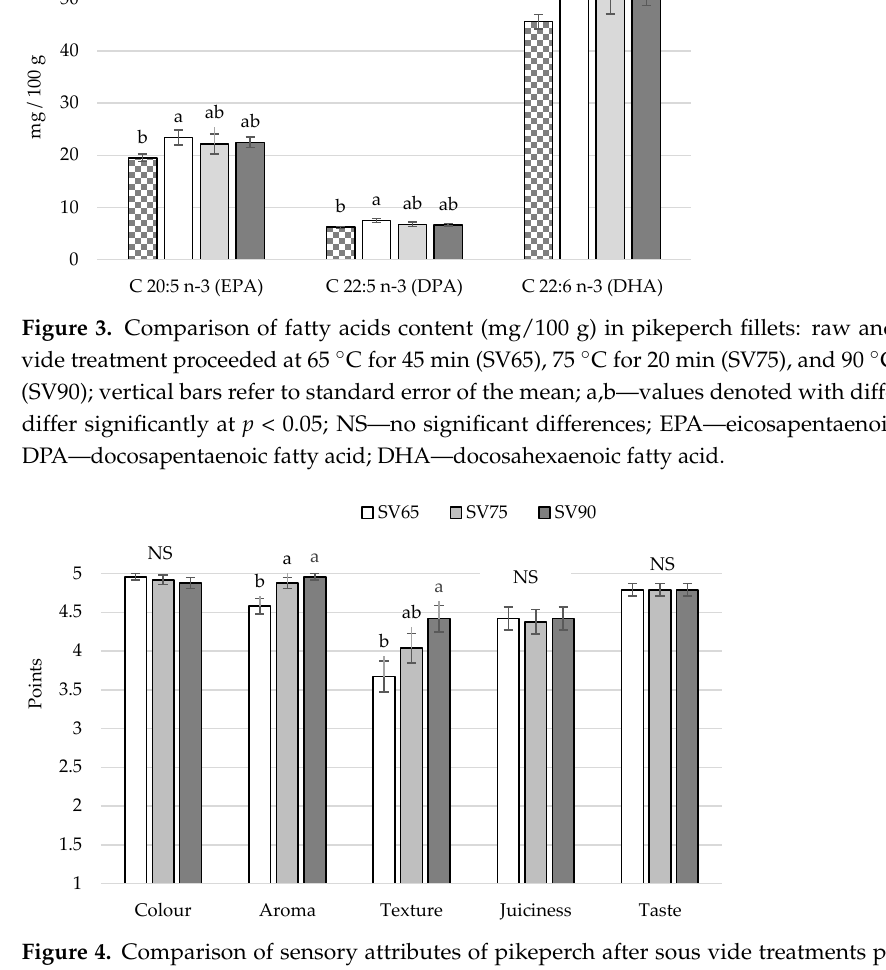
Figure 4. Comparison of sensory attributes of pikeperch after sous vide treatments proceeded at 65 °C for 45 min (SV65), 75 °C for 20 min (SV75), and 90 °C for 10 min (SV90); vertical bars refer to standard error of the mean; a,b — values denoted with different letters differ significantly at p < 0.05; NS — no significant differences.